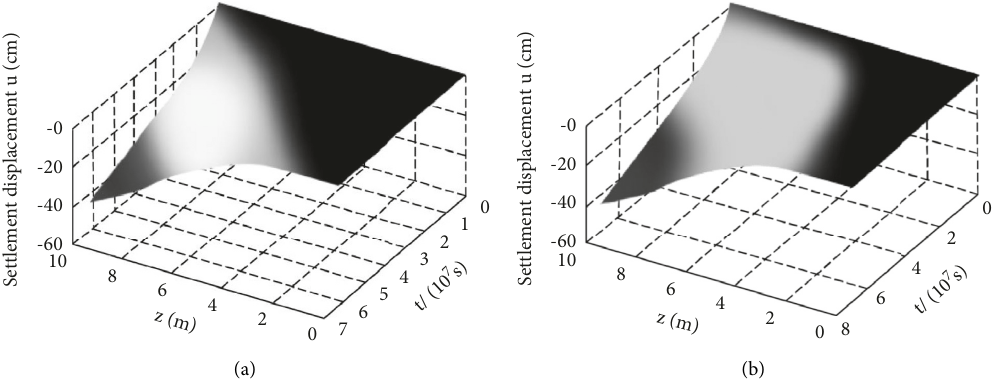
Figure 5: The influence of k 0 on large deformation consolidation when k � k (e) ( e � 1.54). (a) k